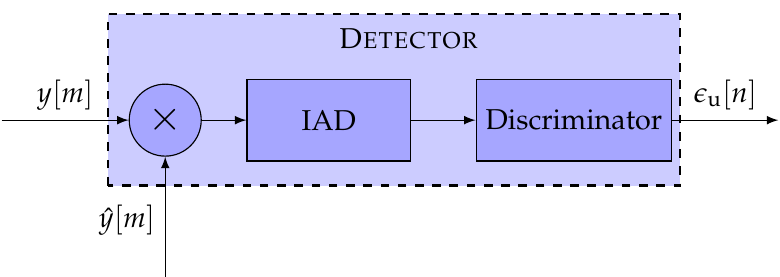
Figure 2. Architecture of the detector. ©IEEE. Adapted, with permission, from [7].